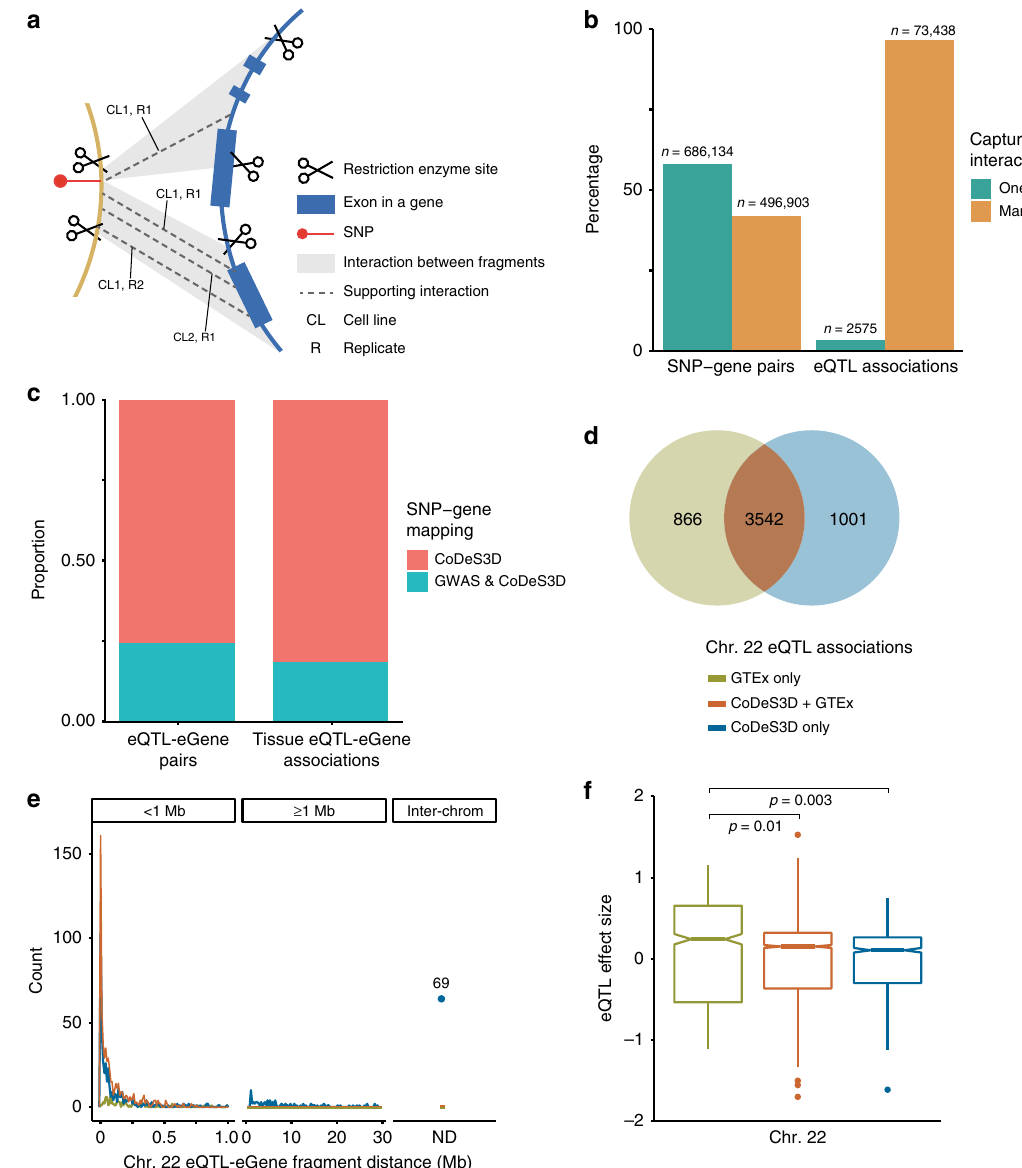
Fig. 1 Integration of interaction data identi fi es distant target genes of GWAS SNPs. A spatial SNP-gene pair is de fi ned as interaction(s), in more than one cell line, between the fragment harbouring the SNP and any fragment(s) in the region spanning the gene. In the cartoon example in a there are two unique fragment interactions between the SNP and gene fragments. One interaction is captured in only one replicate, R1, of cell line, CL1. The second interaction is captured in two replicates, R1 and R2, of cell line CL1, and one replicate, R1, of cell line CL2. Thus, the SNP-gene pair has a total of two fragment interactions, and four supporting interactions. b Genome-wide SNP – gene pairs with ≥ 1 supporting interactions are enriched (two-proportions Z -test p -value< 2.2× 10 − 16 ) for eQTL association. c Integration of spatial data enabled the identi fi cation of genome-wide eQTL-eGene pairs that were missed by GWA studies, which typically used linear proximity to identify the target gene. It is notable that the identi fi cation of eQTL-eGene pairs extended to tissue-speci fi c effects. d The majority of eQTL associations on chromosome 22 are identi fi able by incorporating spatial information (i.e. Hi-C interaction data). Calculation of eQTLs using GTEx alone identi fi ed 866 GTEx-only associations. By contrast, CoDeS3D identi fi ed 1001 associations that had a spatial component. e Integration of spatial data allows for detection of distal eQTL associations on chromosome 22. ND not determinable. f The mean eQTL normalised effect size (NES) of the 1001 spatial eQTL informed associations, on Chr. 22, is signi fi cantly different from the mean eQTL effect size of the 866 associations from only GTEx. Centre line, bounds of box, and whiskers of boxplots represent the median, 2nd and 3rd quartile, and minimum and maximum values, connection between the genomic fragments containing the SNP and gene. Conversely, the integration of spatial data enabled the detection of 1001 spatial eQTL associations, with eQTL NES ranging between − 1.61 and 0.74, that were not detected by the GTEx-only method (Fig. 1d, f). These results are consistent with a signi fi cant number of eQTL effects involving 3D looping interac- tions, up to and beyond 1 Mb. The absence of direct physical